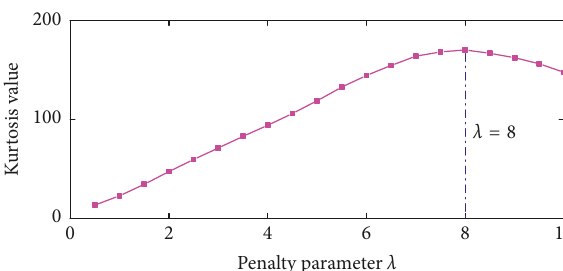
Figure 9: Envelope spectra kurtosis for different values of regu- larization parameter for Case 1.